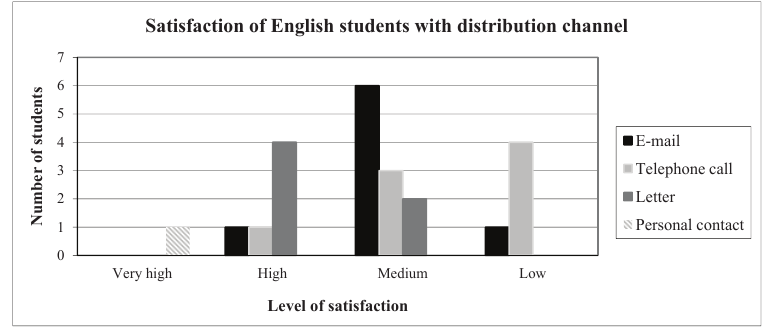
Fig. 6 - Satisfaction with the bank distribution channels among English students. Source: Author´s